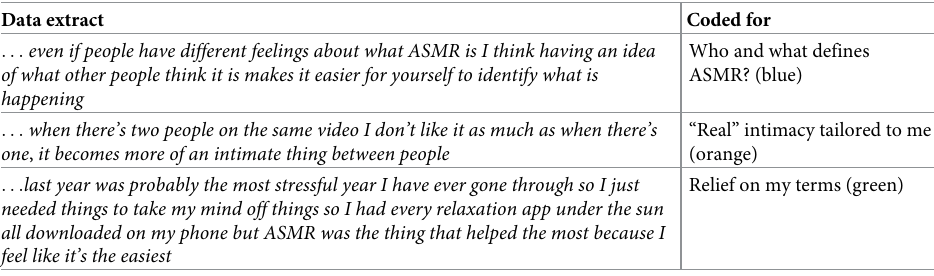
Table 1. Example of colour-coding data for collation into themes,